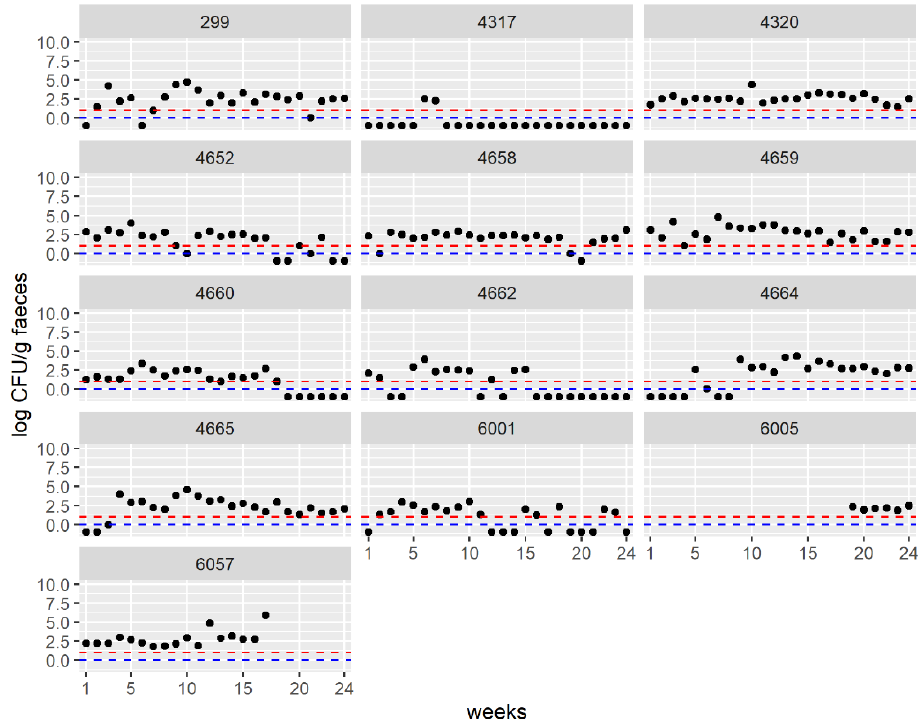
Figure 2. Overview of the concentration of Campylobacter spp. in feces of individual cows (ID numbers). In total, 24 samplings were performed over one year. The first sampling took place in April (week 1). Cow 6057 was replaced by cow 6005 after the 17th sampling. The limits of quantification and detection for enrichment are depicted as a red and blue line, respectively. Dots below the limit of detection indicate negative samples. Dots at the blue line indicate samples that were qualitatively positive but could not be